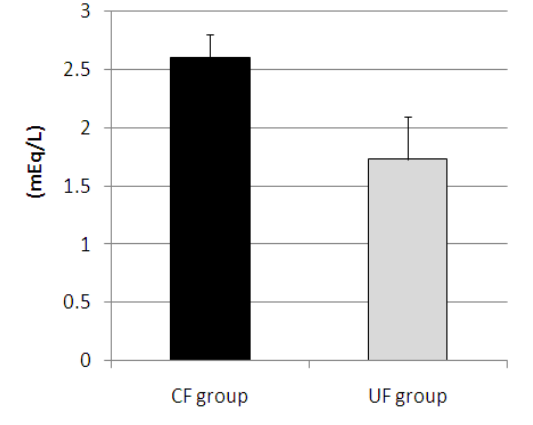
Figure 3. Plasma non-esterified fatty acids (NEFA) concentrations of mice in the ume fiber (UF) and cellulose (CF) groups. Values are means ± SE (n = 7). The data were analyzed using t -test analysis (p =